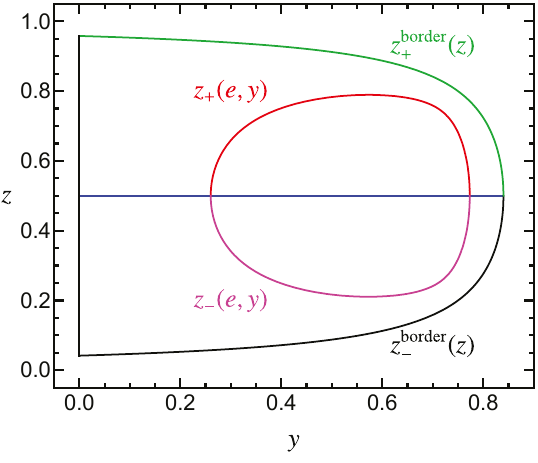
Figure 9 . Phase space diagram in ( y; z ) coordinates depicted as green and black lines, corre- sponding to the functions z border ( z ) and z border ( z ), respectively. The red and magenta lines show + (cid:0) a contour line with constant value of C-parameter, corresponding to the functions z + ( e; y ) and z (cid:0) ( e; y ), respectively. To generate this plot the numerical values ^ m = 0 : 2 and C = 0 : 42 were